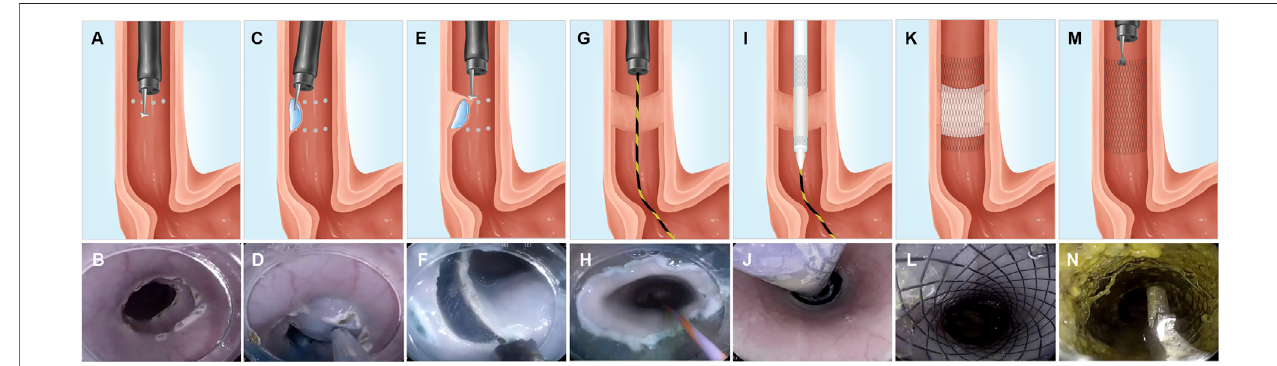
FIGURE 1 | Representative illustrations and corresponding endoscopic views of the ESD procedure and FCSEMS with ADM placement and removal. (A – B) We marked the full circumference on both the cranial and caudal sides, at approximately 30-cm distance from the incisors. (C – D) Submucosal injection of methylene blue and saline between the full circumferential markings of the cranial and caudal sides of an esophageal lesion. (E – F) Submucosal dissection performed with a triangular knife. (G – H) PlacementofaguidewireunderendoscopicguidanceafterfullcircumferentialESD. (I – J) Astentconveyerisinsertedalongwiththeguidewire,andthe FCSEMS with ADM was placed by driving the stent conveyer. (K – L) Outcome of FCSEMS with ADM placement. (M – N) Stent removal using forceps. FCSEMS, fully covered self-expanding metal stent; ADM, acellular dermal matrix.